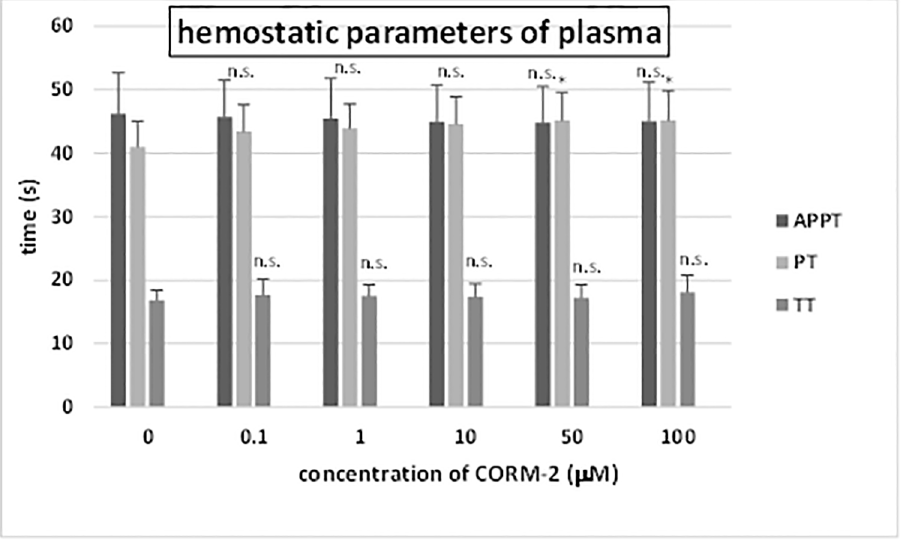
Fig 6. The effect of CORM-2 (0.1–100 μ M, incubation time– 30 min) on the hemostatic parameters of human plasma (APPT, PT and TT). Data represents means ± SD of 10 experiments (from different donors). * p < 0.05 vs . control, n.s. p > 0.05 vs .